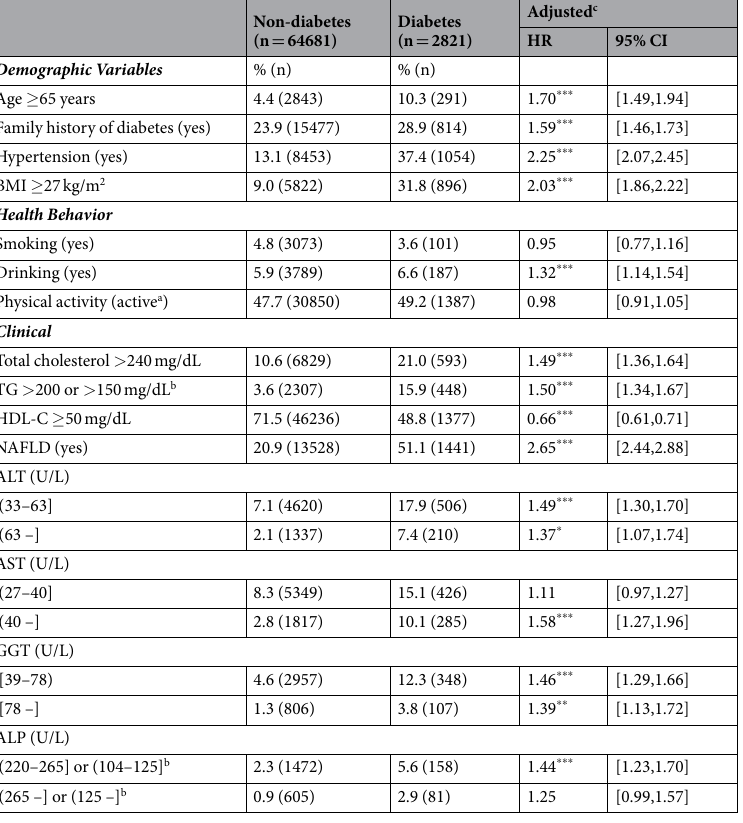
Table 5. Adjusted hazard ratio (HR) of type 2 diabetes in women (stratification for liver-related enzymes). 95% confidence intervals (CI) in brackets. * p < 0.05, ** p < 0.01, *** p < 0.001. Abbreviations: FPG, fasting plasma glucose; TG, triglycerides; HDL-C, high-density lipoprotein cholesterol; NAFLD, non alcoholic fatty acid disease; ALT, alanine transaminase; AST, aspartate transaminase; GGT, gamma-glutamyltransferase;